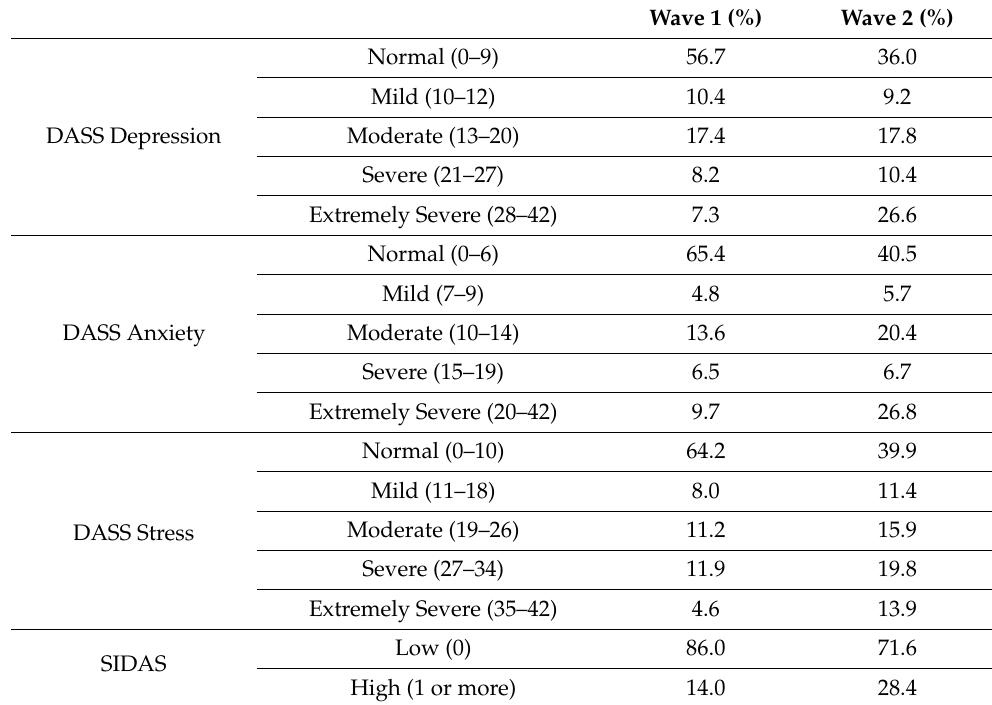
Table 3. Distribution of DASS Depression, DASS Anxiety, DASS Stress, and SIDAS scores by category in the first and the Omicron wave, in the total